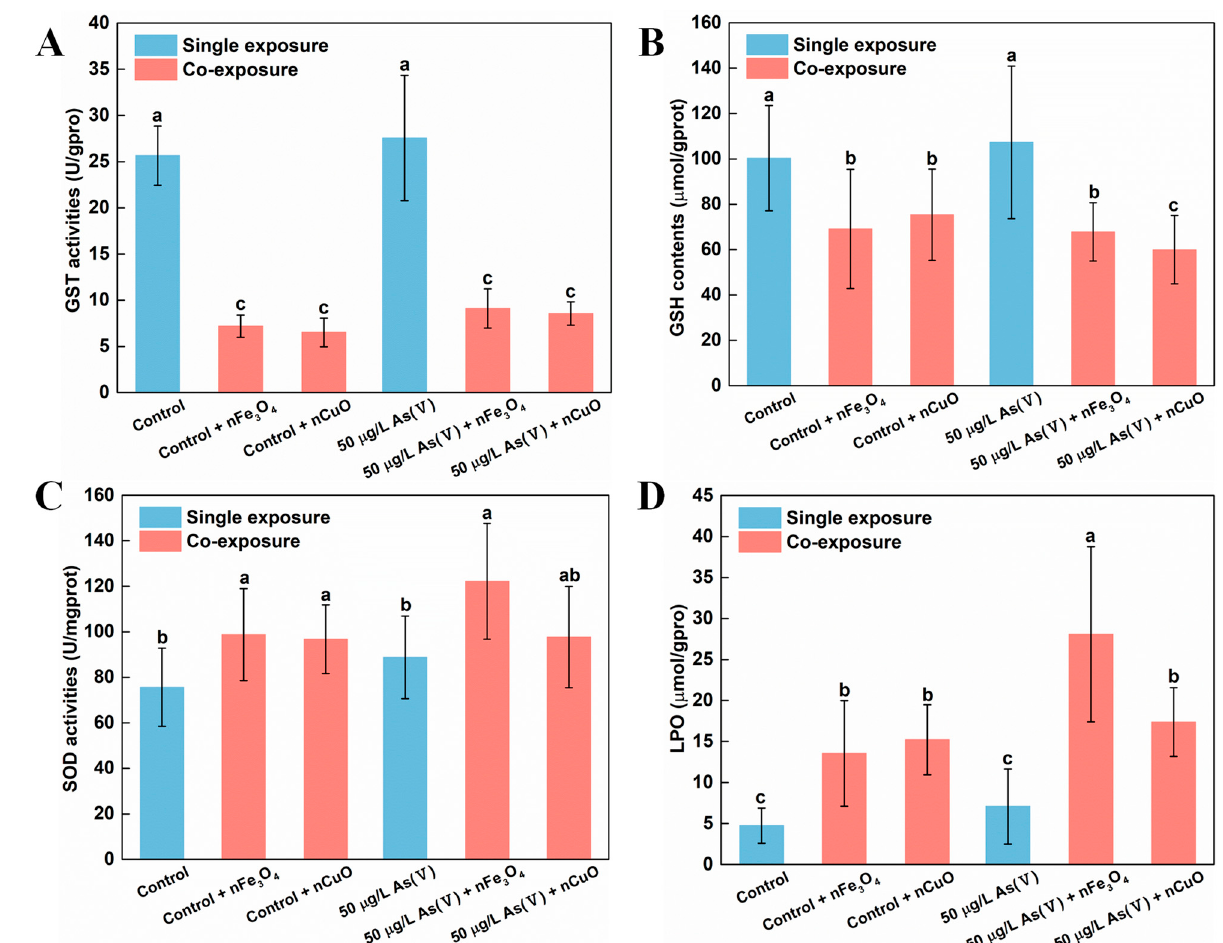
Figure 5. Biomarker values in mussels after different exposure. ( A ) GST activities, ( B ) GSH contents, ( C ) SOD activities and ( D ) LPO levels in mussel exposed to different treatments at the end of the exposure (mean ± SD, n = 6). Significant differences ( p < 0.05) among exposure conditions were represented with different letters. Control: Mussels exposed to artificial seawater for 21 days (single exposure). Control + nCuO: Mussels exposed to 1 mg/L nCuO for 2 weeks after control exposure (co-exposure). Control + nFe 3 O 4 : Mussels exposed to 1 mg/L nFe 3 O 4 for 2 weeks after control exposure (co-exposure). 50 μ g/L As(V) only: Mussels were cultured in 50 μ g/L As(V) solution for 21 days (single exposure). 50 μ g/L As(V) + nCuO: Mussels exposed to 50 μ g/L As(V) + nCuO for 2 weeks after 50 μ g/L As(V) exposure (co-exposure). 50 μ g/L As(V) + nFe 3 O 4 : Mussels exposed to 50 μ g/L As(V) + nFe 3 O 4 for 2 weeks after 50 μ g/L As(V) exposure (co-exposure).